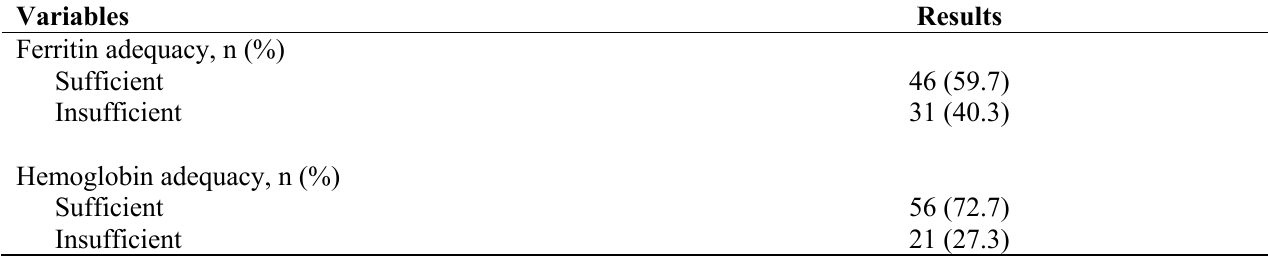
Table 3 . Subjects’ adequacy of ferritin and hemoglobin levels